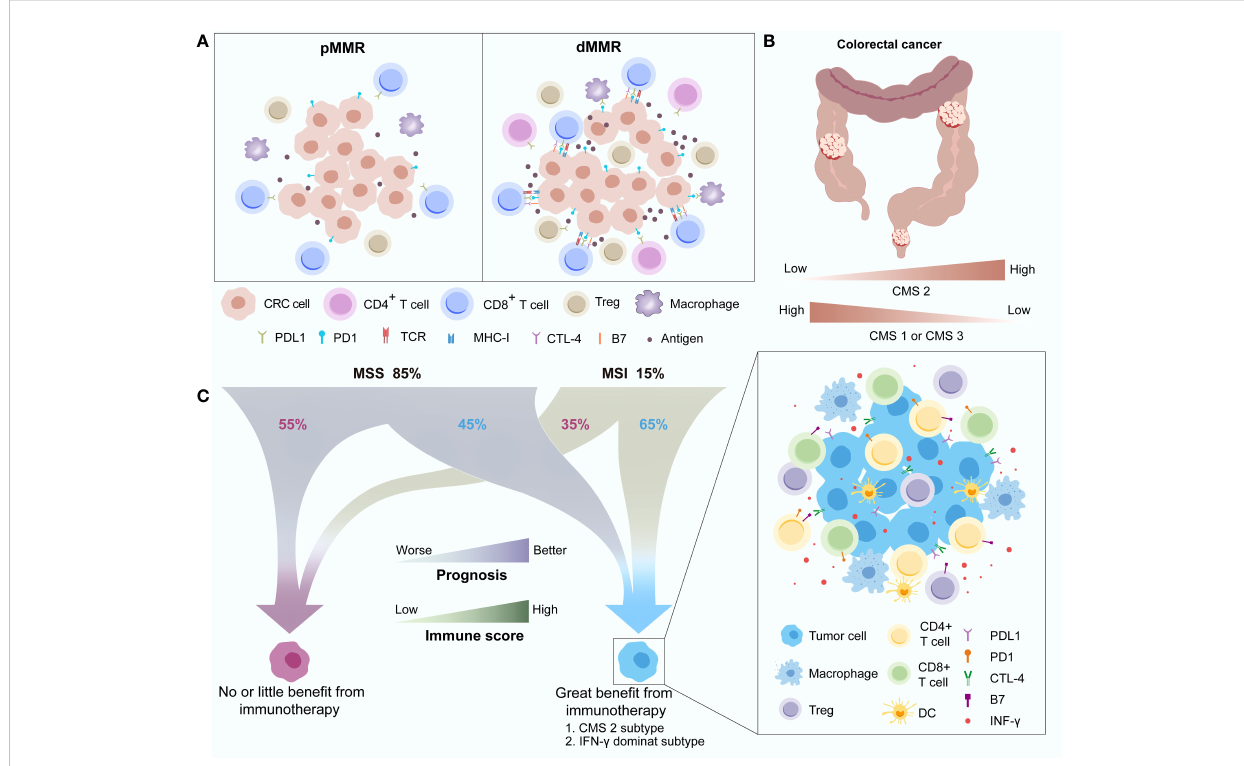
FIGURE 3 Differences in the immune landscape between pMMR and dMMR in CRC (A) and the distribution (B) and characteristics (C) of different immune subgroups. CMS, Consensus molecular subgroup; CRC, Colorectal cancer; CTLA-4, Cytotoxic T-lymphocyte-associated antigen-4; DC, Dendritic cell; dMMR, De fi cient mismatch repair; IFN- g , Interferon gamma; MSI, Microsatellite instability; MSS, Microsatellite stability; PD-1, Programmed death-1; PD-L1, Programmed death-ligand 1; pMMR, Pro fi cient mismatch repair; TCR, T-cell